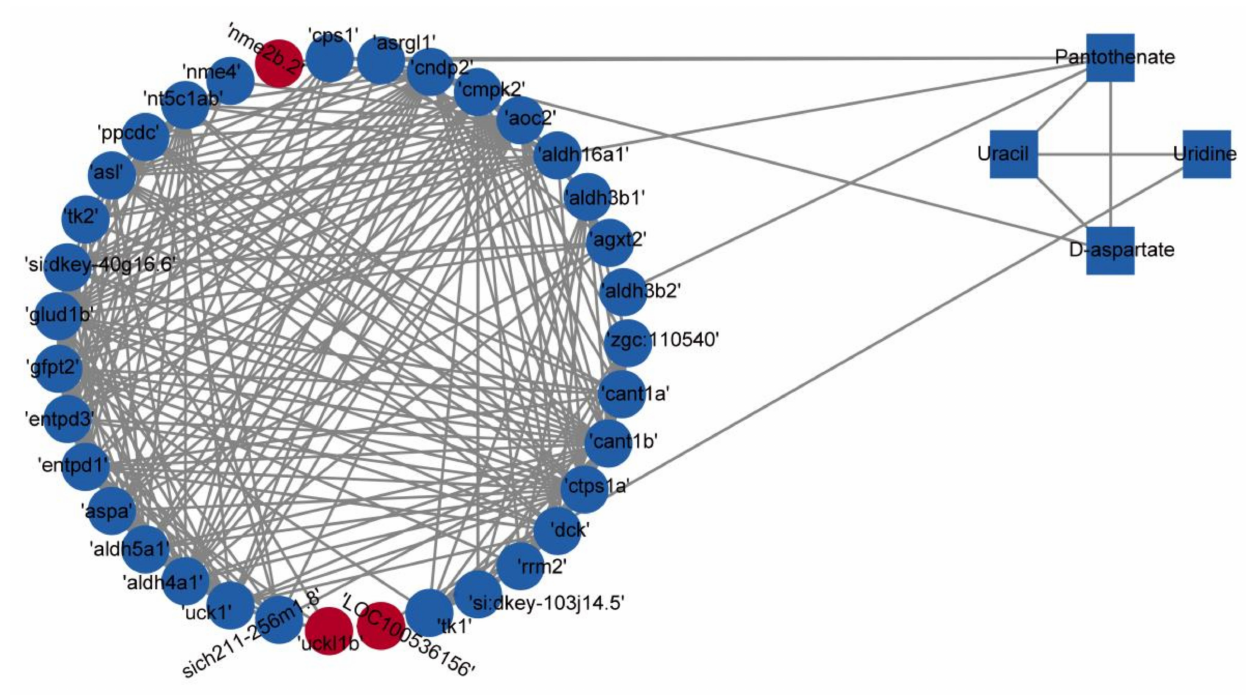
Figure 7. Correlation-based networks of metabolites and genes in the four identified pathways. Rectangles represent metabolites, and circles represent genes. Red indicates upregulation, and blue indicates downregulation.